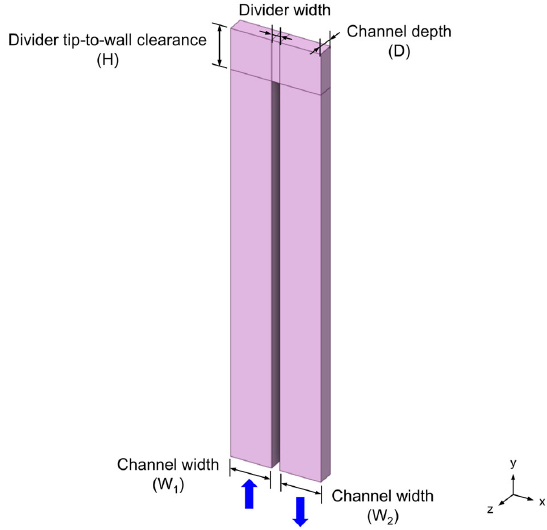
Figure 2. 3D model of a sharp 180° turn in smooth rectangular channels.